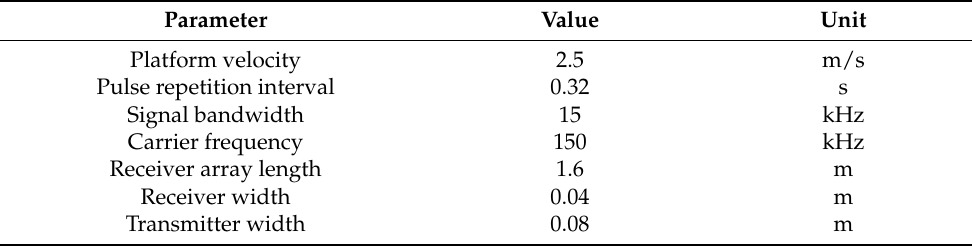
Table 2. SAS parameters.